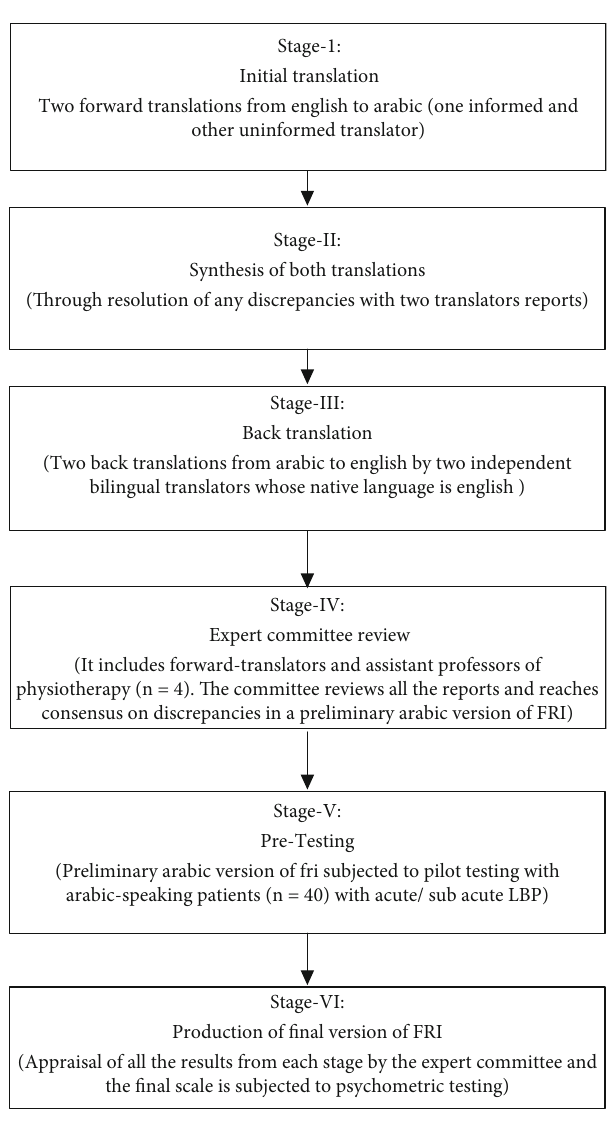
Figure 3: Stages of translation and cross-cultural adoption of Functional Rating Scale-Arabic